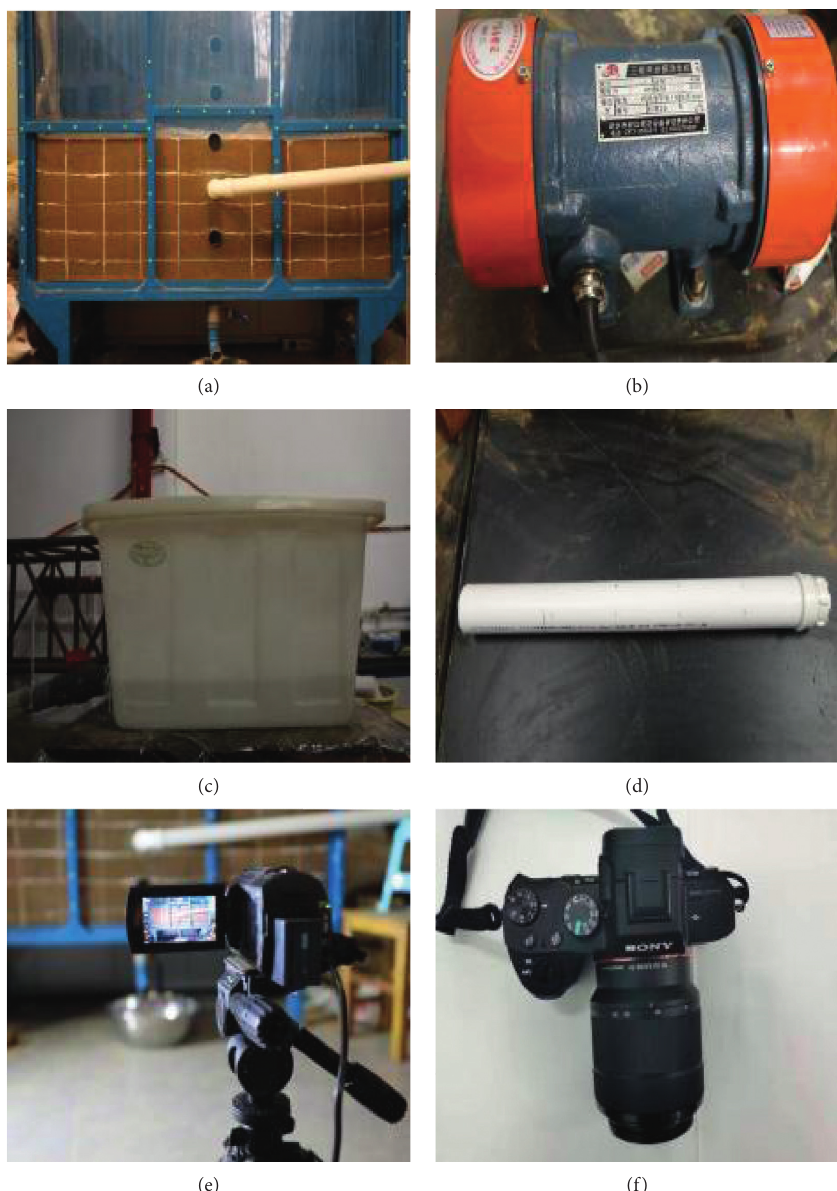
Figure 1: Experimental devices. (a) Model box. (b) Vibration exciter. (c) Water tank. (d) PVC pipe. (e) Video recorder. (f)